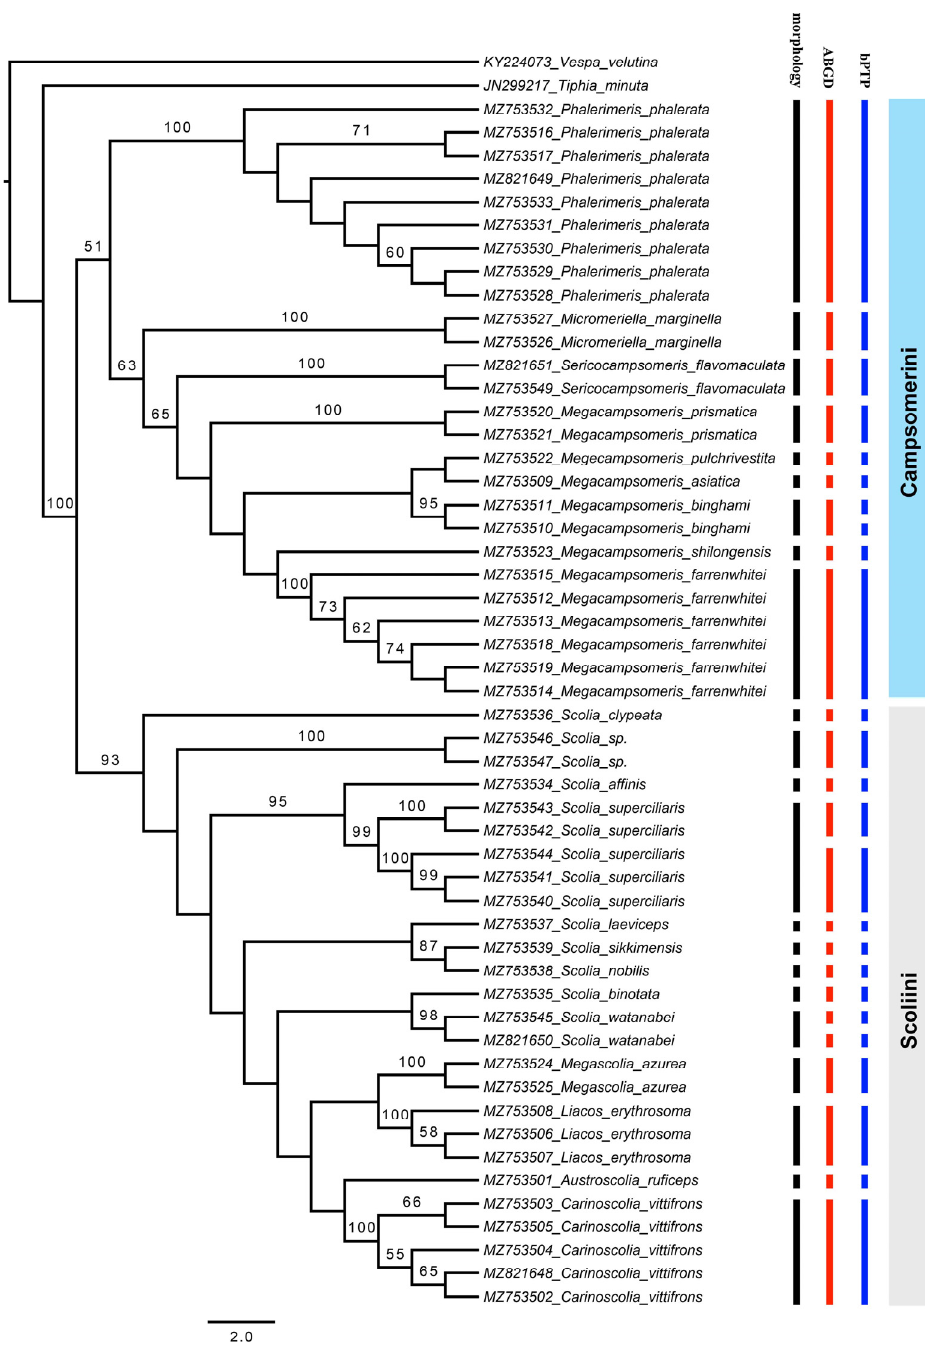
Figure 1. Maximum likelihood tree based on COI and results of species delimitation of three methods, only values > 50 for bootstrap are labeled.